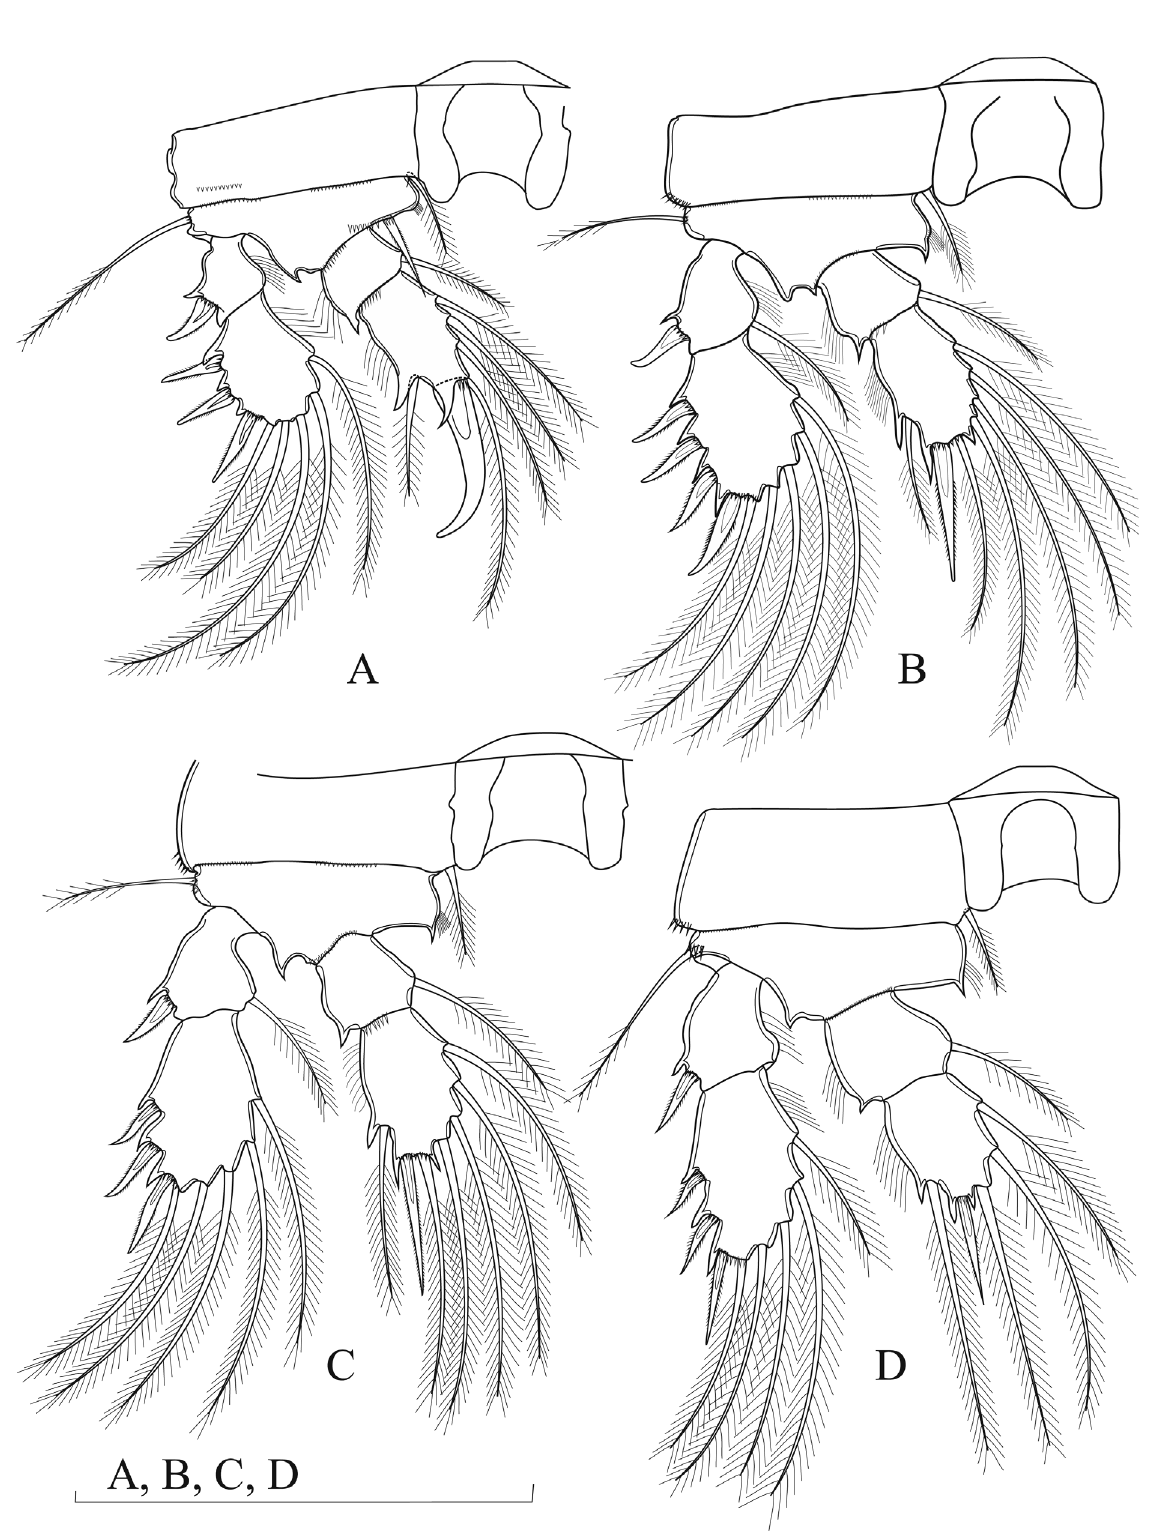
Fig. 8. Metacyclops thailandicus sp. nov., holotype, ♀. A . P1. B . P2. C . P3. D . P4. Scale bar: 100